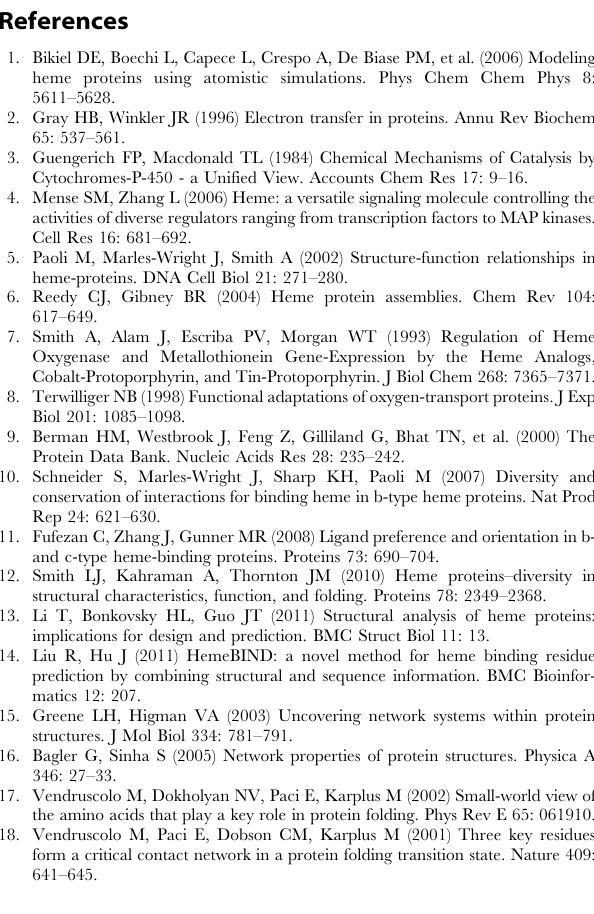
Table S1 Comparison of network-based features based on different residue type. (PDF) Table S2 Comparison of the prediction performance on Dataset 2. (PDF) Table S3 Comparison of the prediction performance on 26 heme proteins. (PDF) Table S4 Comparison of the prediction performance for individual holo structure.